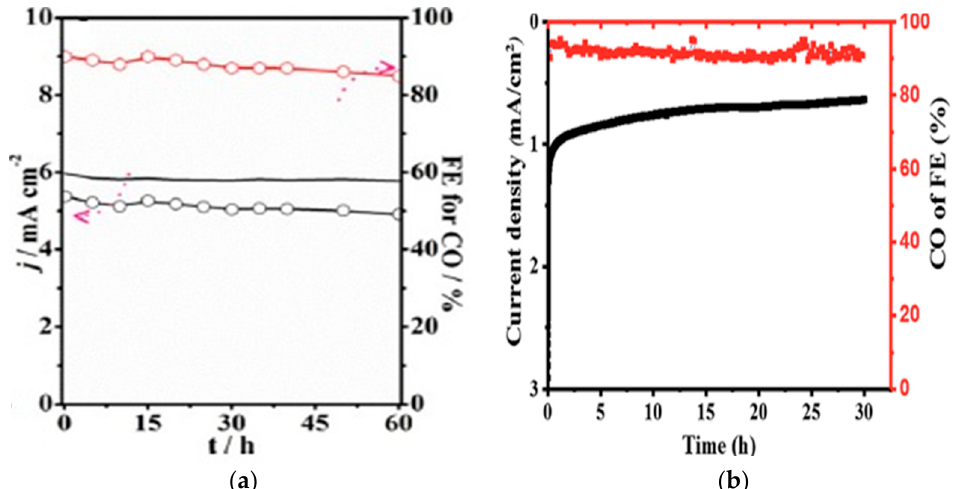
Figure 2. ( a ) Stability test (total current density, faradaic efficiency, and current density for CO production) of nitrogen-doped carbon nanotubes at − 0.9 V vs. a reversed hydrogen electrode (RHE), reproduced from [57], Copyright (2020), with permission from John Wiley and Sons. ( b ) Stability test on a 1D/2D nanorod array/nanosheets-900 electrode at − 0.45 V in CO 2 -saturated 0.5 M KHCO, reproduced from [82], Copyright (2020), with permission from the Royal Society of Chemistry.